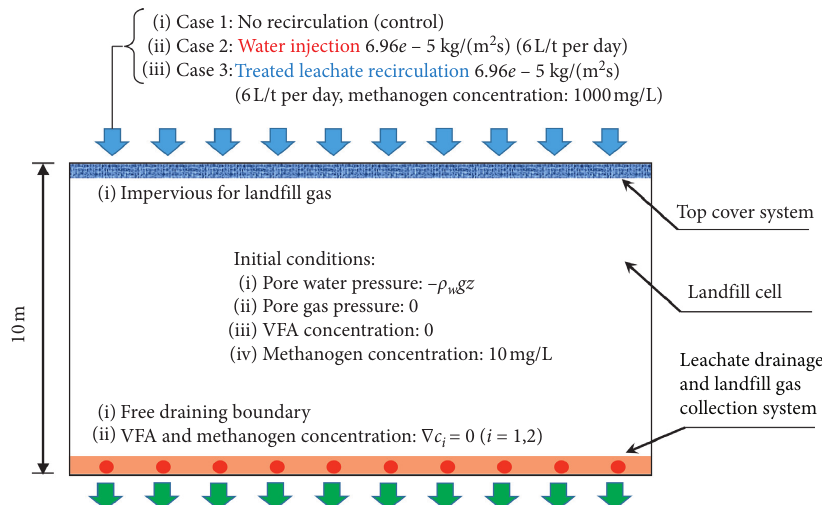
Figure 2: A hypothetical case of the high kitchen waste-content landfill cell with different leachate recirculation conditions. Table 1: The coupled model